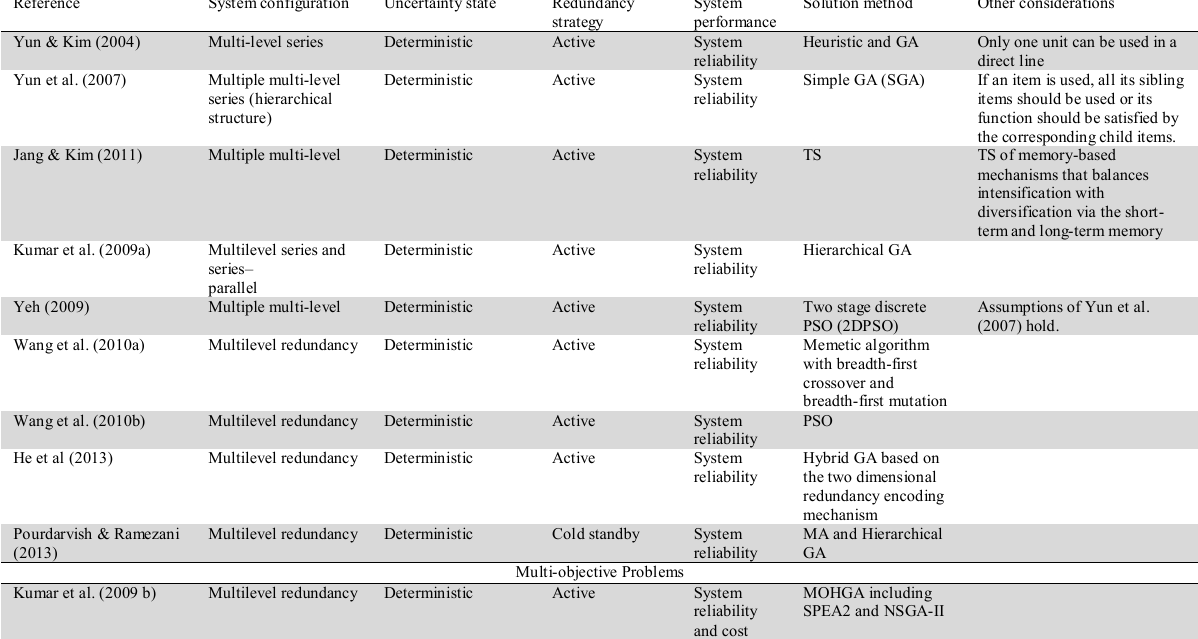
Multi-level redundancy